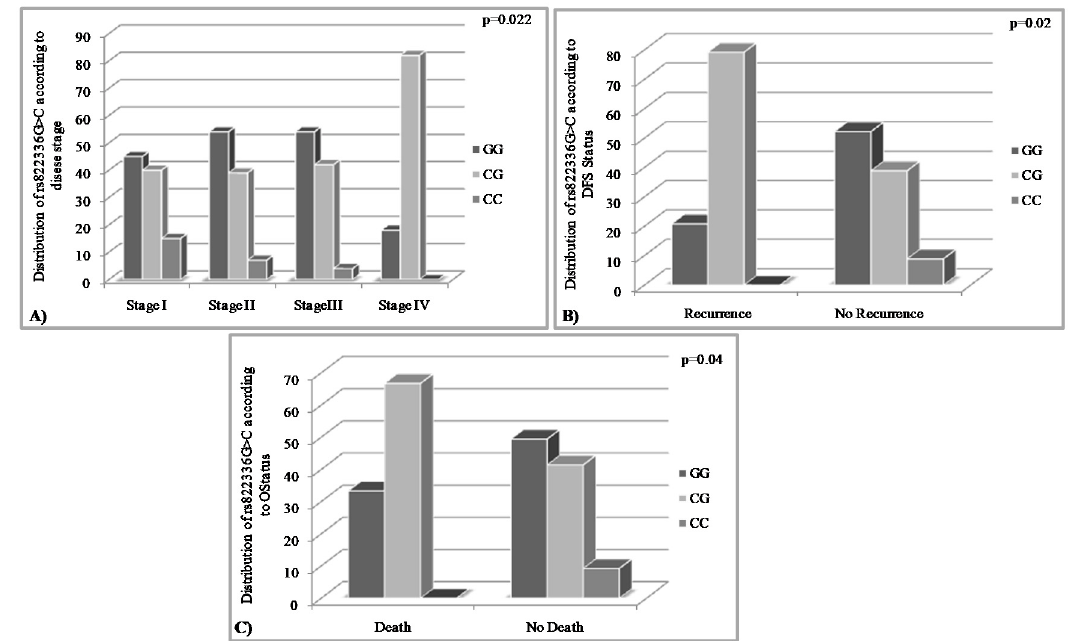
Figure 2. Distribution of the rs822336 G>C according to TNM Stage ( A ), DFS ( B ) and OS Status ( C ).